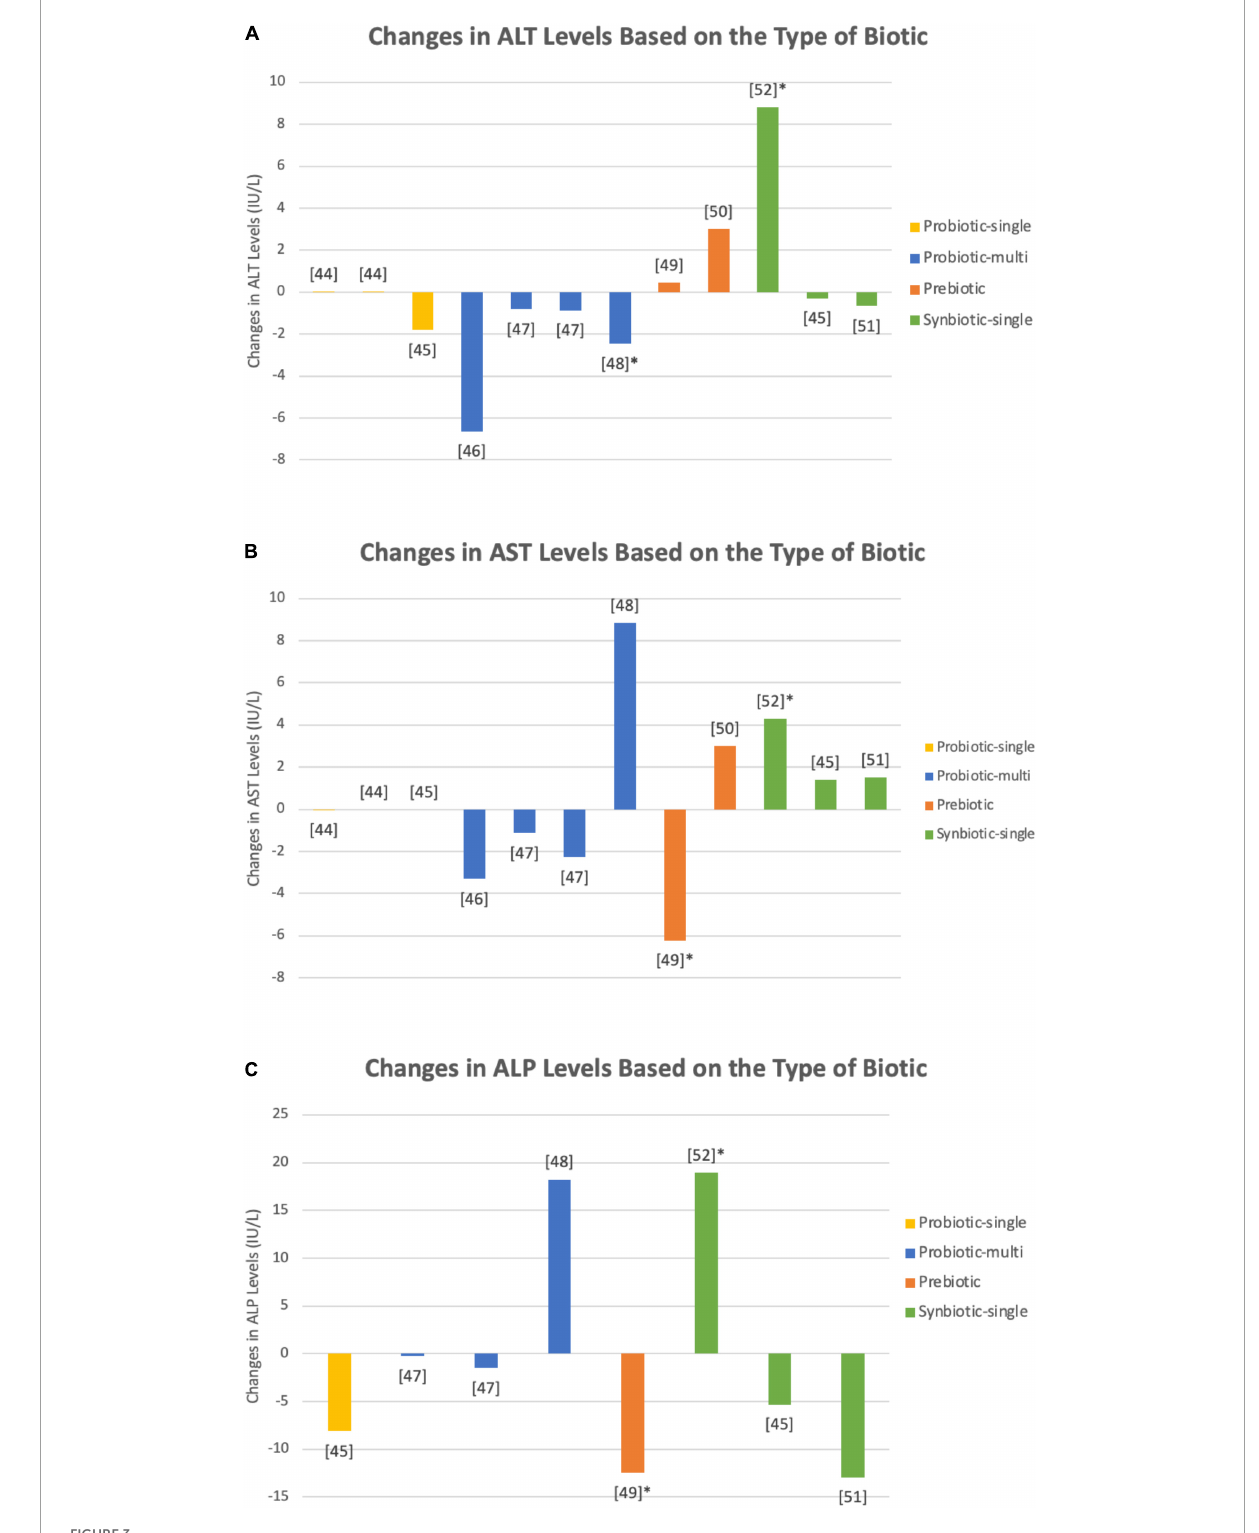
FIGURE3 Changes in (A) ALP, (B) ALT, and (C) AST levels upon administration of single species probiotics (yellow), multi-species probiotics (blue), prebiotics (orange), and single species synbiotics (green) in nine studies (47–55). Bars marked with an asterick represent significant changes in the respective biomarker levels. Both single species L. reuteri (47) and B. coagulans (48) showed insignificant alterations in ALP, ALT, and AST